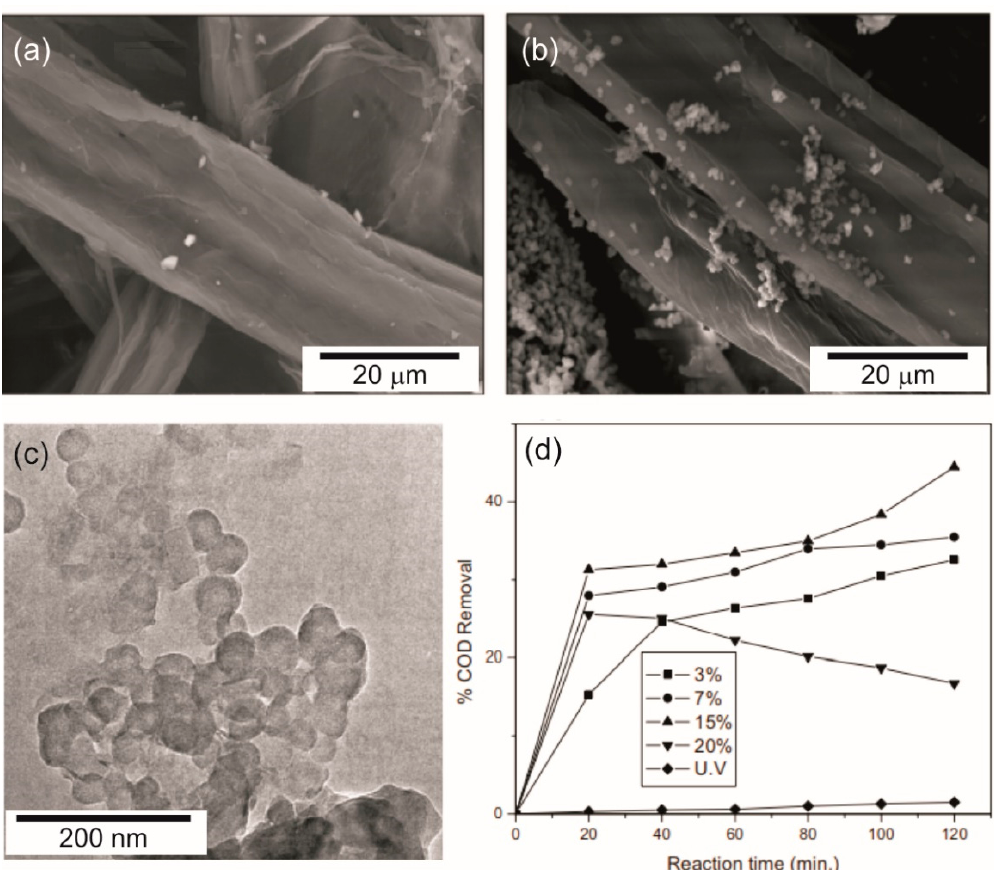
Figure 7. ( a ) SEM images of the photocatalytic paper containing 7% and ( b ) 20% of TiO 2 /Sodium alginate nanocomposite, and ( c ) transmission electron microscopy (TEM) images of the nanocomposite. ( d ) Photocatalytic degradation for the removal of chemical oxygen demand of wastewater. Reproduced with permission of Elsevier [185] .